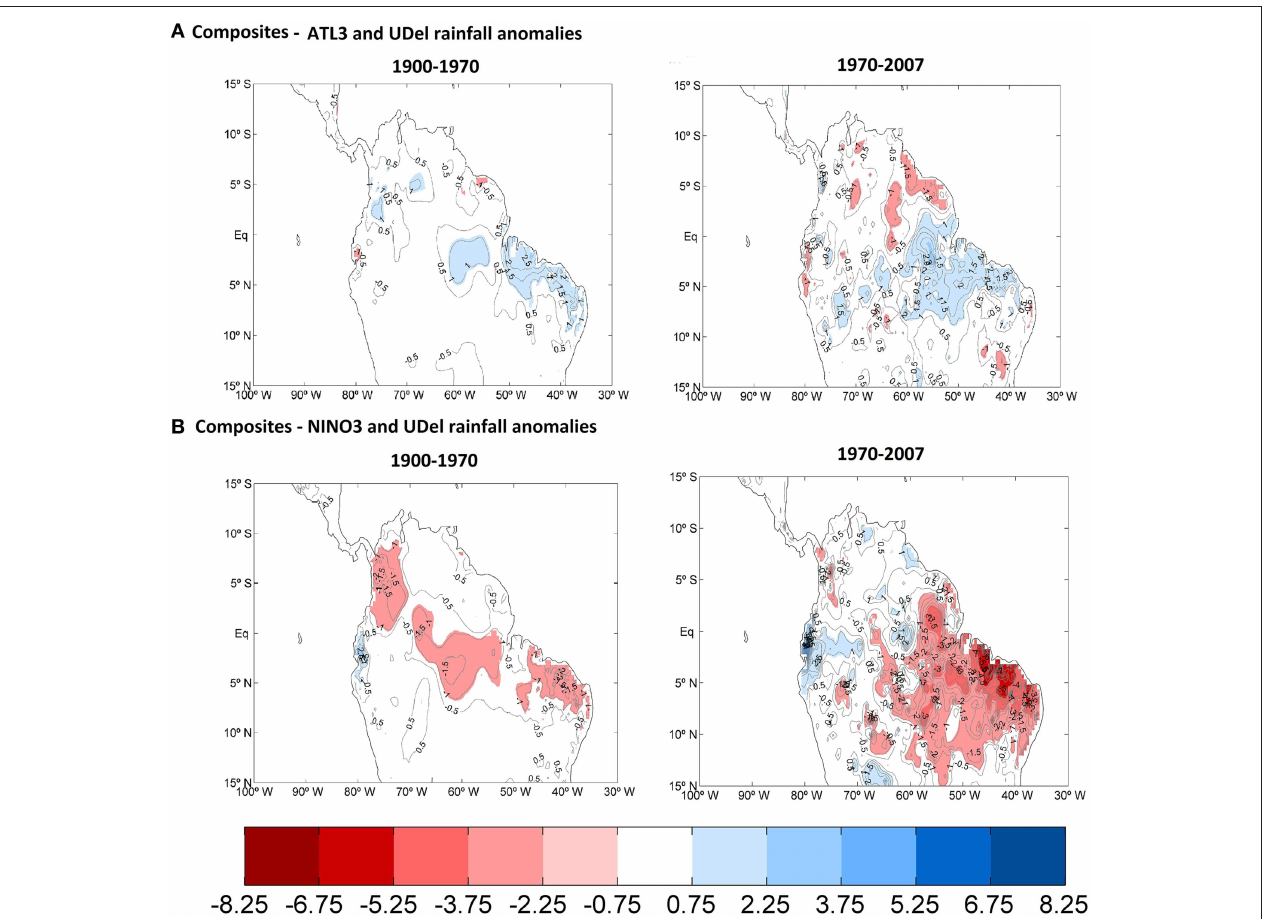
FIGURE 4 | Difference between the composite map of the UDel rainfall (mm/day) for the event. (A) ATL3 > 1 minus the composite map for the event ATL3 < − 1 in the period before 1970 (left column) and after 1970 (right column). (B) NINO3 > 1 minus the composite map for the event NINO3 < –1 in the period before 1970 (left column) and after 1970 (right column). Contoured areas represent the values of the differences, expressed in mm/day, while the regions with correlations significant at the 95% level are